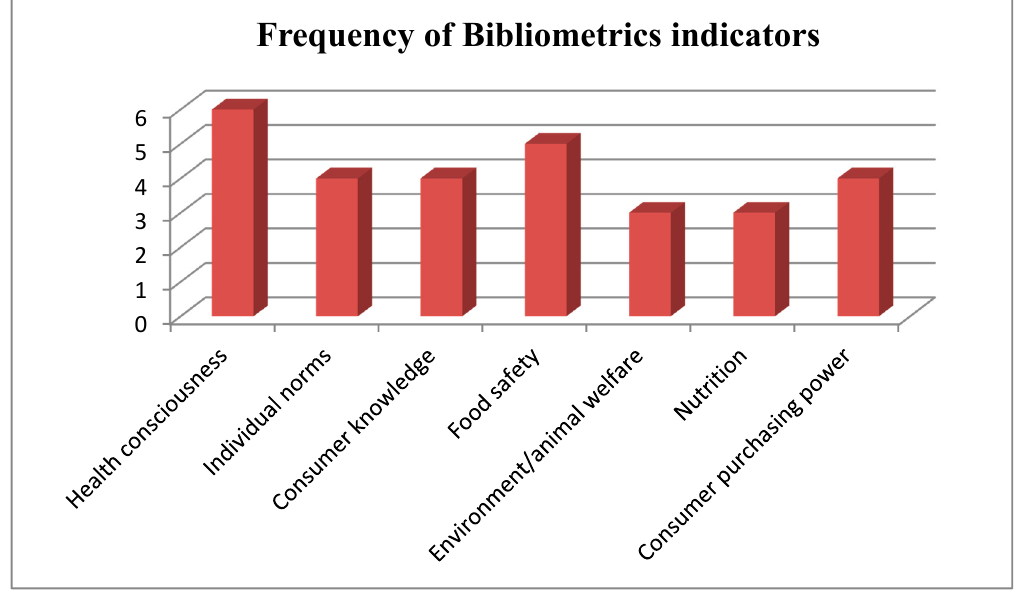
Figure 2. Keywords that were most cited.